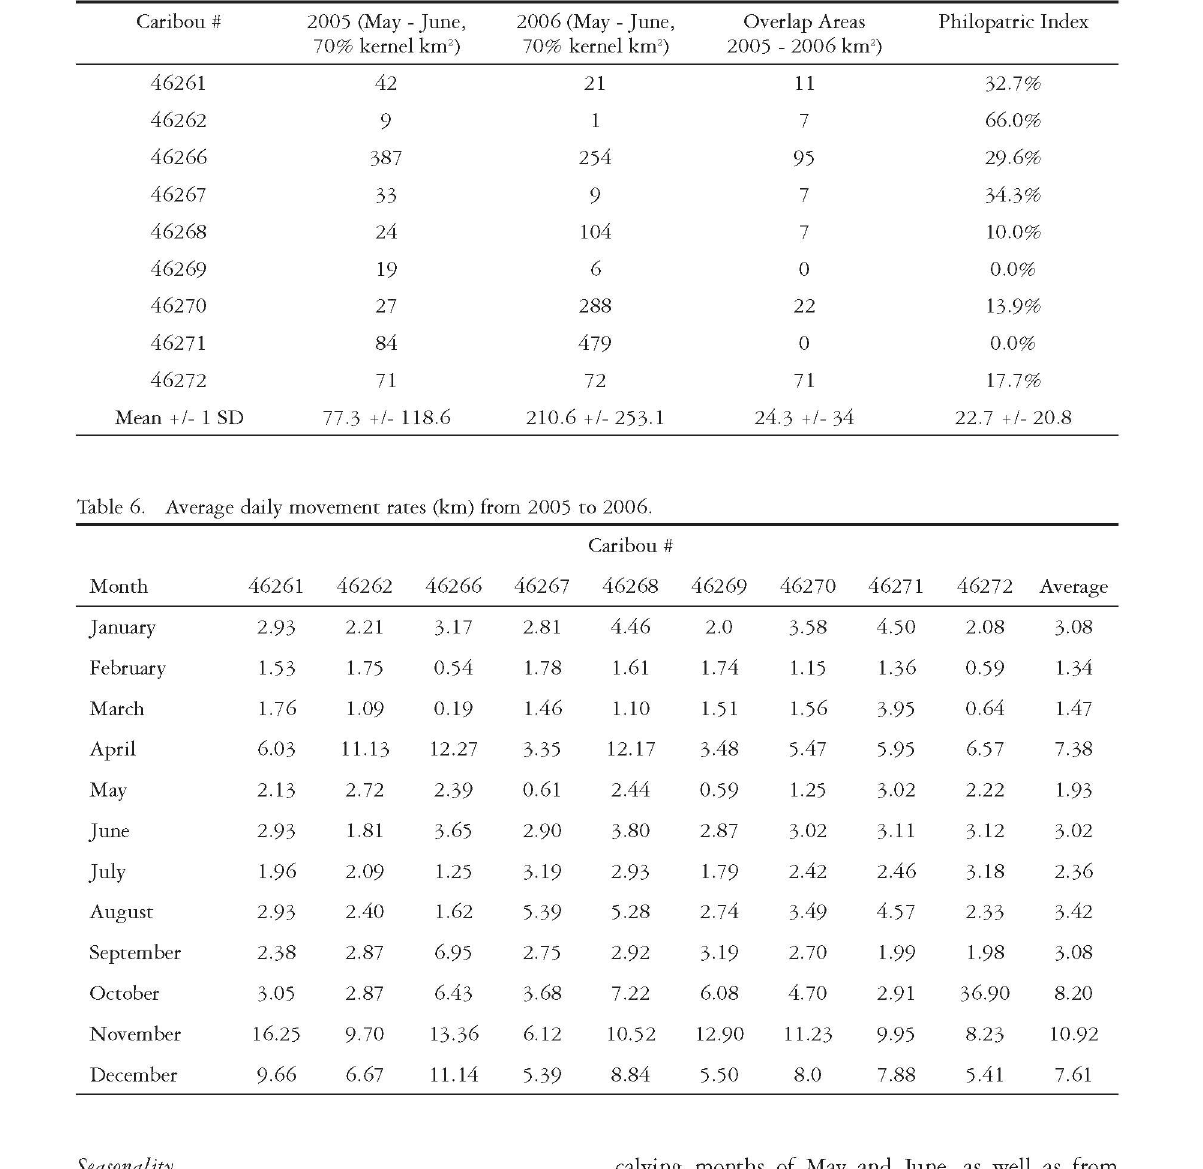
Table 5. Size of core calving areas for 9 caribou in 2005 and 2006 with estimates of site fidelity (philopatric index). Caribou #